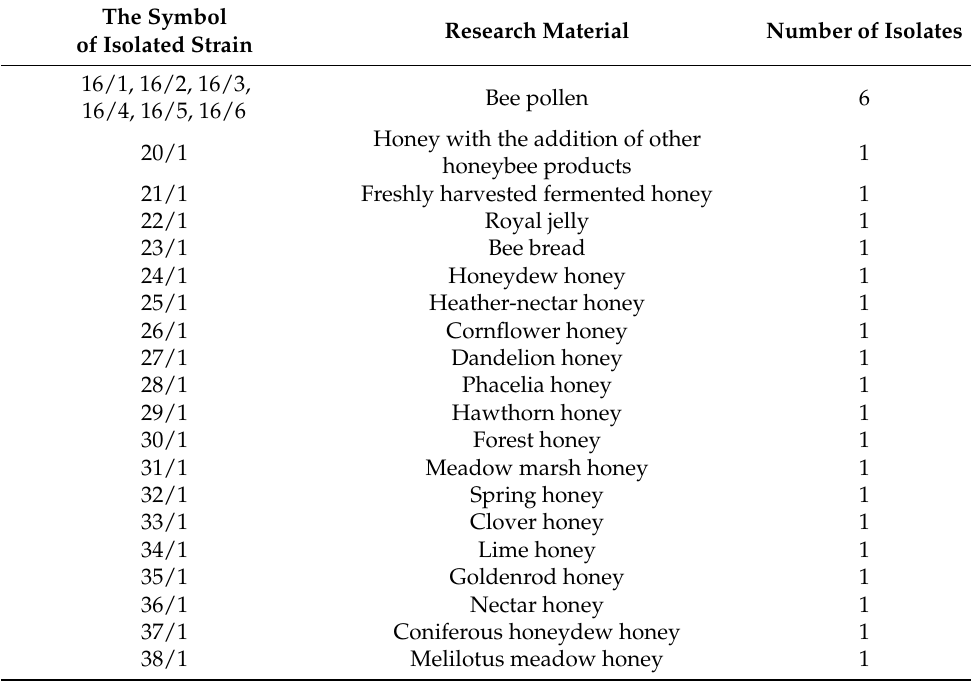
Table 3. LAB strains isolated from honeybee products (harvested from May to August